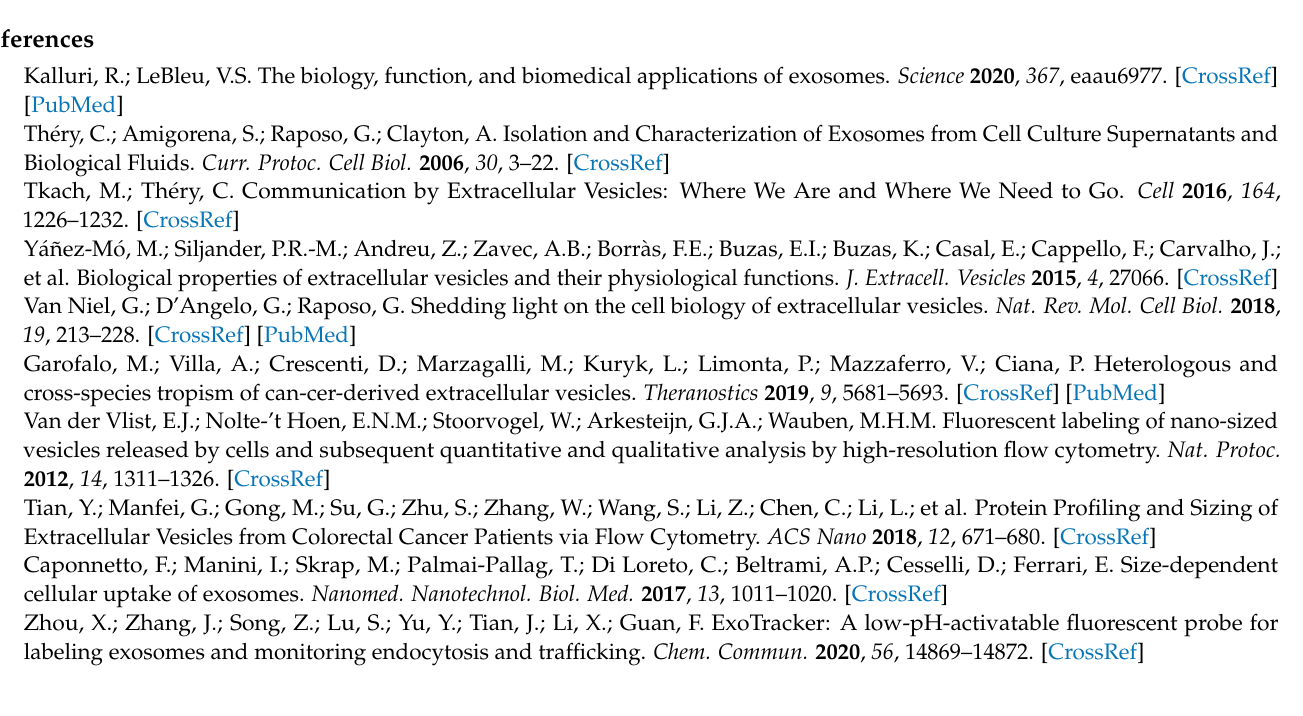
NTA, Figure S1: TEM images of the JAr EVs purified with SEC. Scale bars of 500 nm are displayed within the figures, Figure S2: TEM images of the JAr EVs purified with TFF in combination with SEC. Scale bars of 500 nm are displayed within the